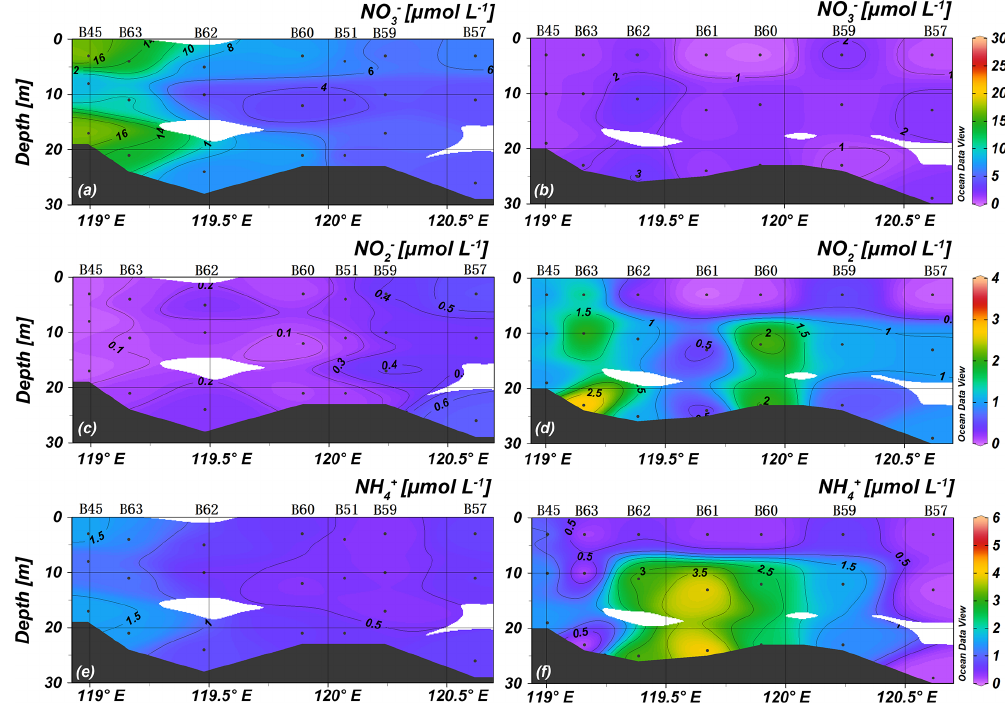
Figure 4. Nutrients of section 1 (µmolL − 1 ) for spring (a, c, e) and summer (b, d, f) .